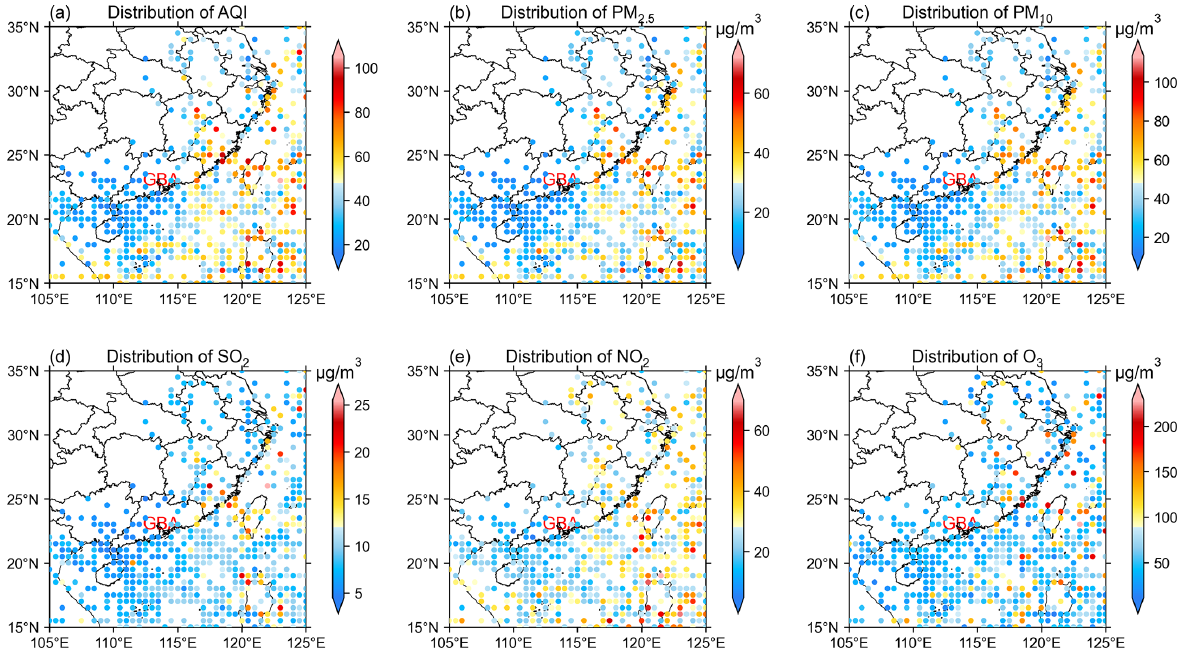
Figure 6. The correlation of air quality over the GBA and typhoon center location predicted by the model. (a) The correlation of AQI and typhoon center location predicted by the model, as well as for (b) PM 2 . 5 , (c) PM 10 , (d) SO 2 , (e) NO 2 and (f) O 3 . The scattering points indicate the average value of air quality when the typhoon is located in the corresponding location. Table 3. Evaluation metrics of the model prediction of the case of Danas in the